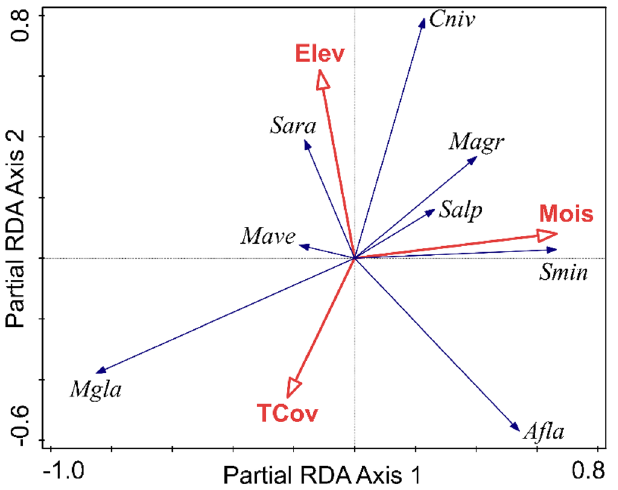
Figure 3. Species—habitat biplot diagram from partial RDA (year included as covariate) summarising the effects of tree cover (TCov), soil moisture (Mois) and elevation (Elev) on the species composition (response data were standardised by site total). The codes for species are given by the initial of genus and first three letters of species name. The length of the arrows representing the predictors is given by the strength of their correlation with the first two ordination axes (indicated by the projection of the arrows on the two axes). The angle between arrows indicates the correlation between individual variables. The angle between species arrows indicates the correlation between the relative abundances of species (positive when the angle is sharp). The length of the arrow is a measure of fit for the